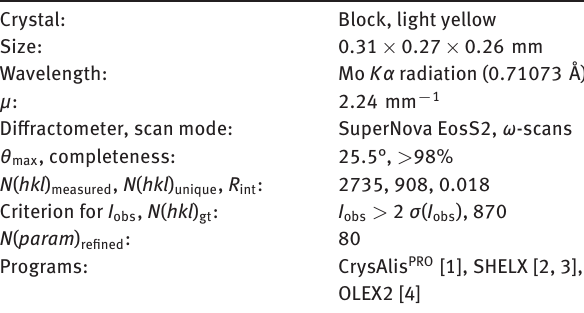
Table 1: Data collection and handling.